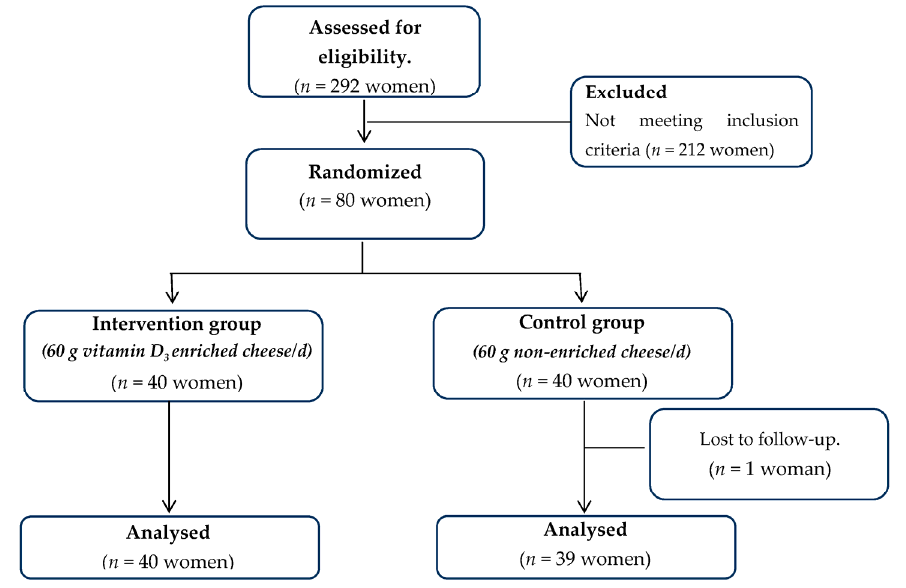
Figure 1. CONSORT flow diagram of study participants.